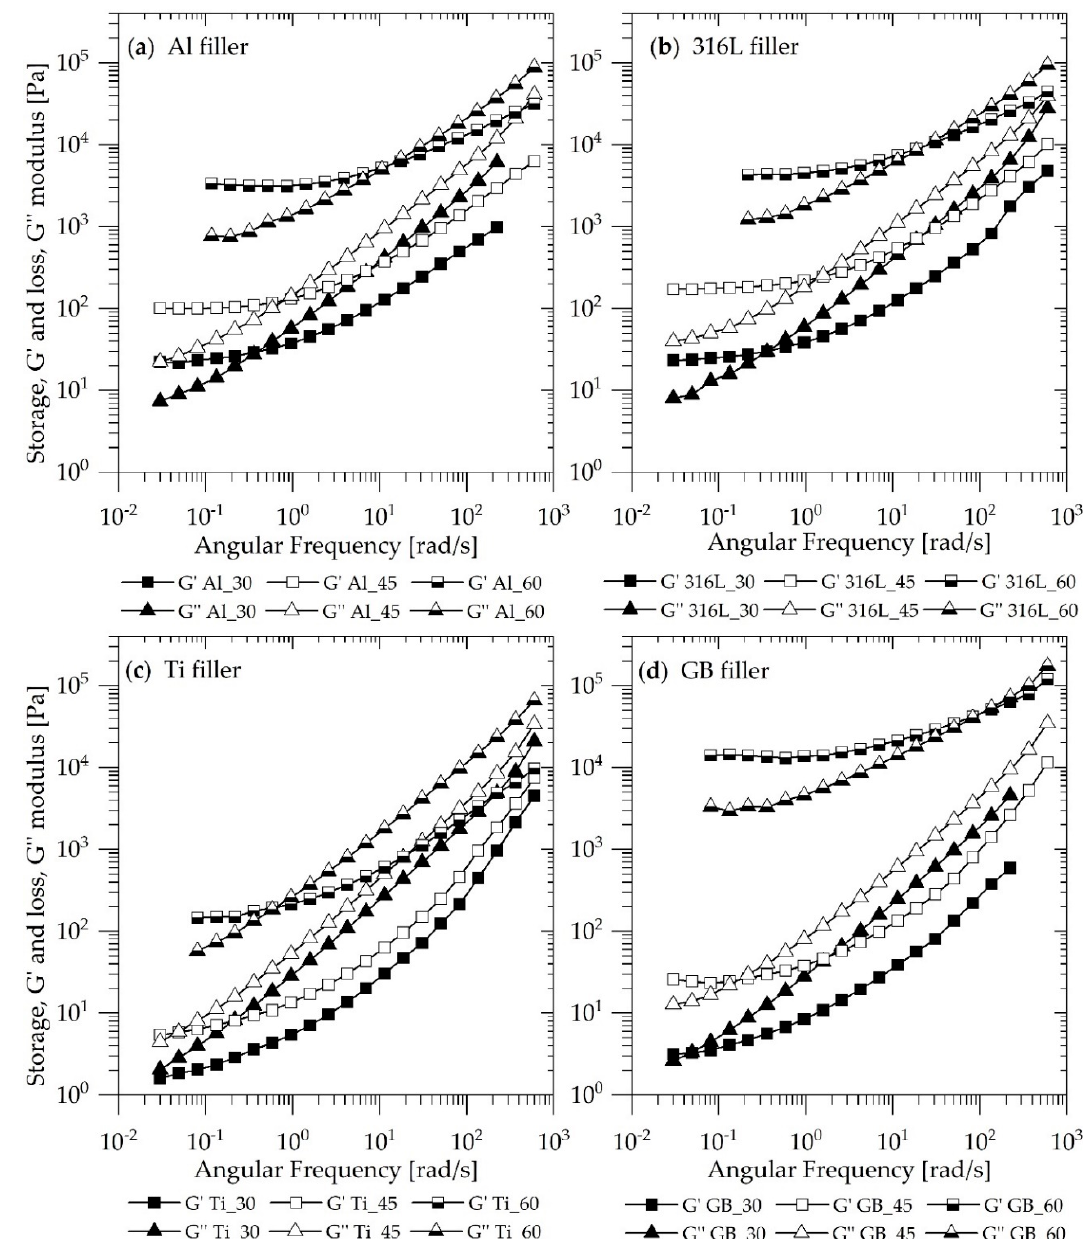
Figure 7. The effect of filler concentration on storage, G ′ and loss G ″ modulus as a function of angular Figure 7. The e ff ect of filler concentration on storage, G (cid:48) and loss G” modulus as a function of angular frequency: ( a ) Al filler, ( b ) 316L filler, ( c ) Ti filler, and ( d ) GB filler. frequency: ( a ) Al filler, ( b ) 316L filler, ( c ) Ti filler, and ( d ) GB